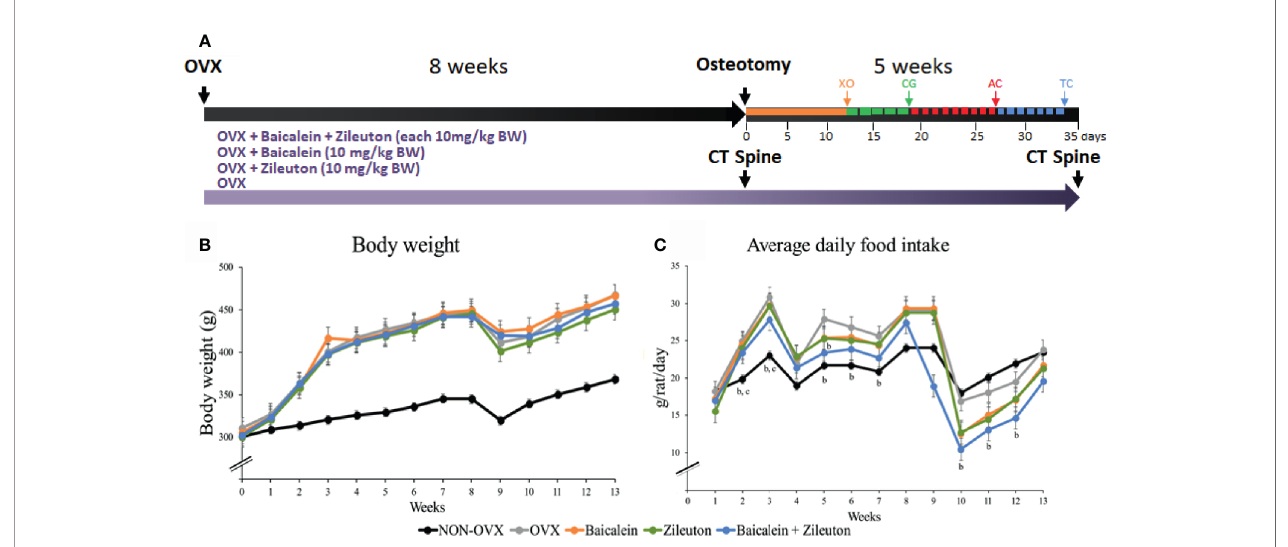
FIGURE 1 | Graphical abstract of experimental setup. (A) After ovariectomy, 13 weeks-treatments with either Baicalein, Zileuton or their combination were conducted. Bilateral tibia osteotomy was performed 8 weeks after OVX. In vivo CT of the spine was executed after 8 and 13 weeks. On day 12, xylenol orange was administered, on day 19 calcein green, on day 27 alizarin complexone, followed by tetracycline on day 33. (B) The body weight of rats (g). (C) The average daily food intake (g/rat/day). b Differs from OVX. c Differs from Baicalein.